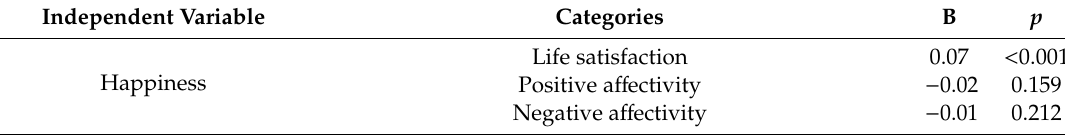
Table 3. Associations of happiness and nursing work environments with job crafting among